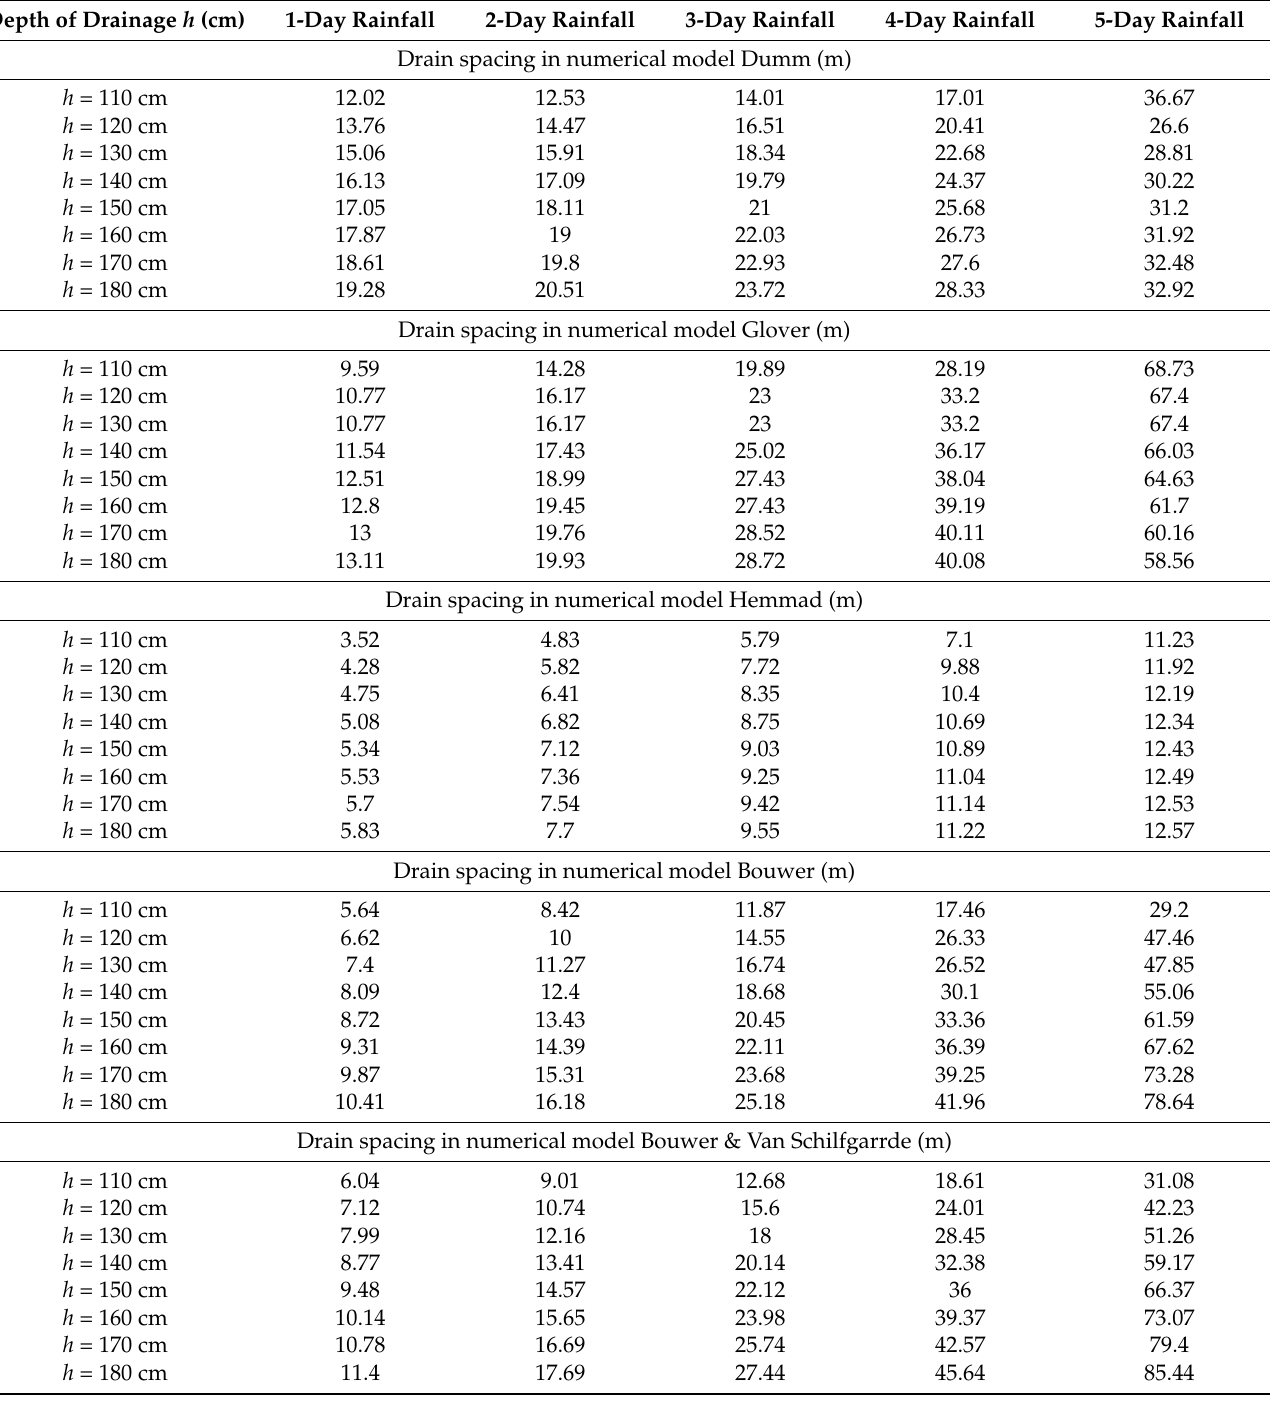
Table 4. Distances between computational drains based on numerical elationships in time-dependent conditions at a depth of 110 cm; 18 cm above the ground and under a rainfall of 1–5